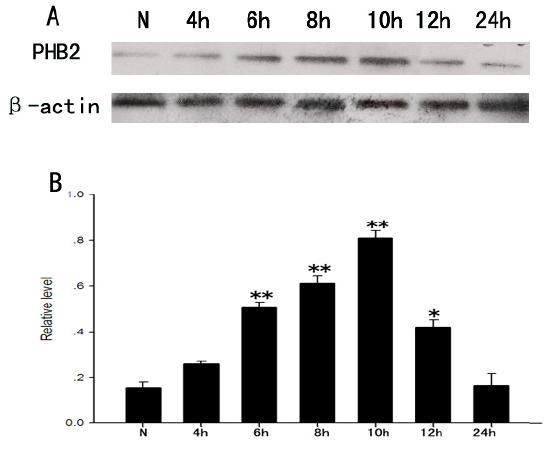
Figure 9. The expression change of PHB2 in the process of the proliferation of astrocytes stimulated by LPS. ( A ) The time courses of PHB2 expressions in astrocytes after LPS stimulus; β -actin was used to confirm equal amounts of protein was run on gel; ( B ) Quantification was made at each time point, the bar chart showed the ratio of PHB2 to β -actin at each time point; these data are means ± SEM, * p < 0.05, ** p < 0.01 ( n =